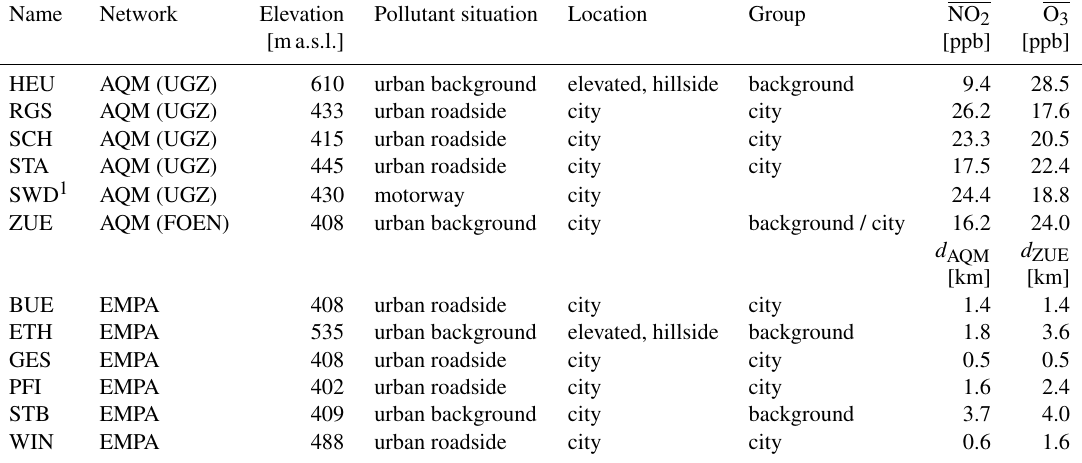
Table 1. List of the air quality monitoring (AQM) sites and the sensor network sites. NO 2 and O 3 denote the NO 2 and O 3 annual mean concentrations in 2015, respectively. d AQM denotes the distance of the sensor network location to the next AQM site, d ZUE denotes the distance to the AQM site ZUE. AQM sites in Zurich are operated by the Environment and Health Protection Department (UGZ, City of Zurich) and the Federal Office for the Environment (FOEN). A map of the AQM sites and the sensor network is included in the